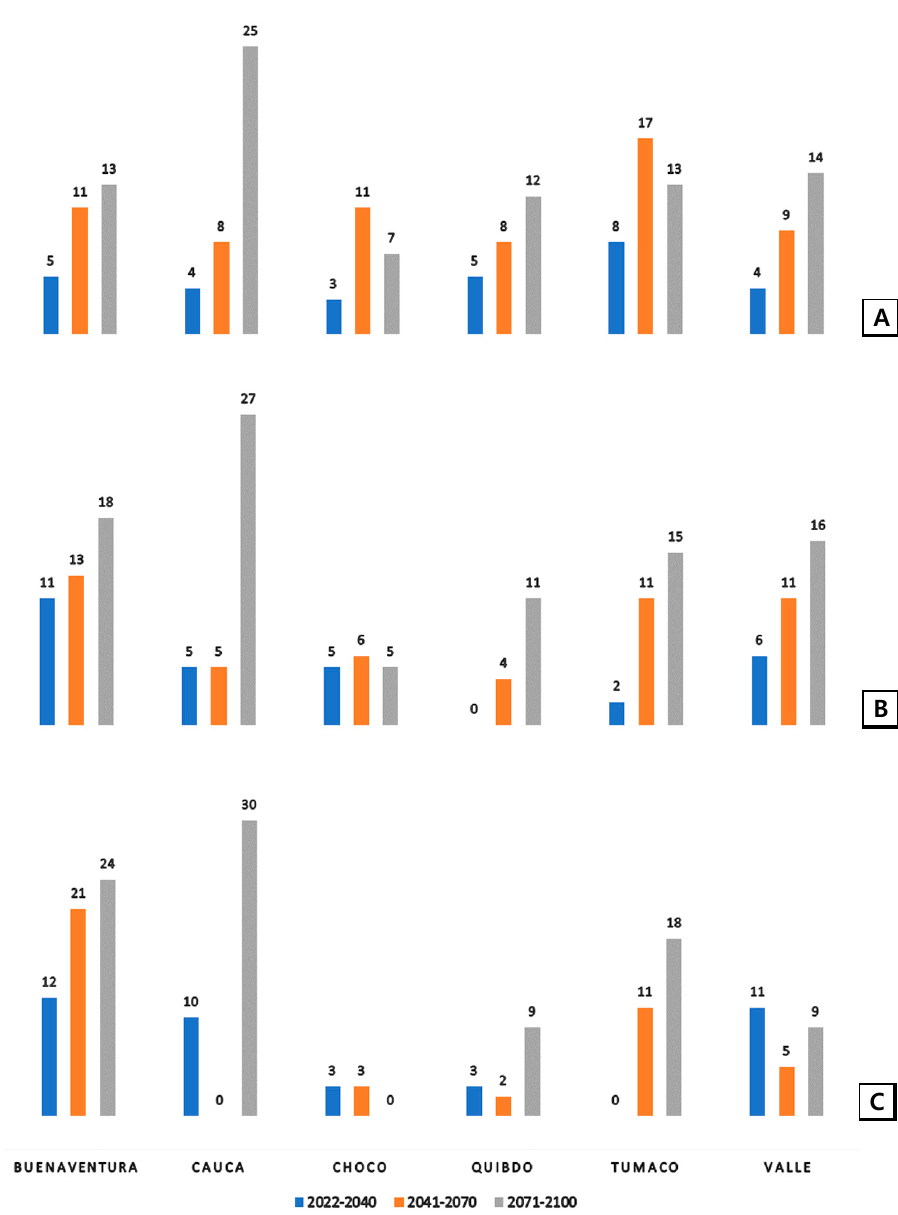
Figure 8. Number of Extremely Dry events in Colombia’s Pacific region under the RCP 8.5 scenario (2022–2100). ( A ) SPI 3; ( B ) SPI 6; and ( C ) SPI 12.